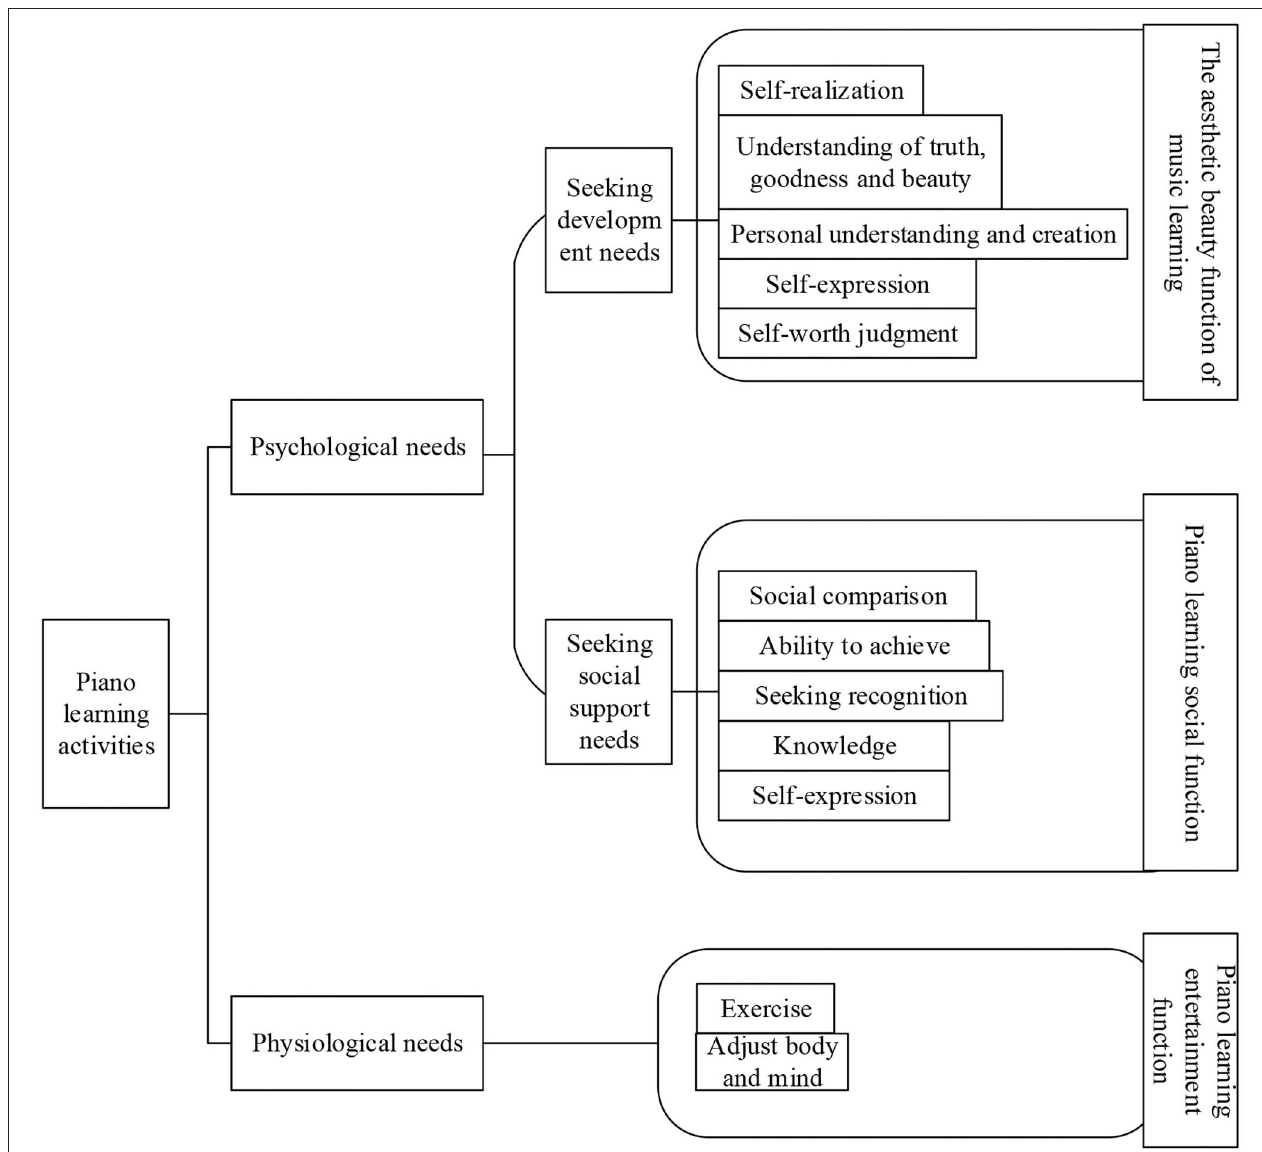
FIGURE 8 | The model of psychological experience of piano learning to improve the subjective well-being of the